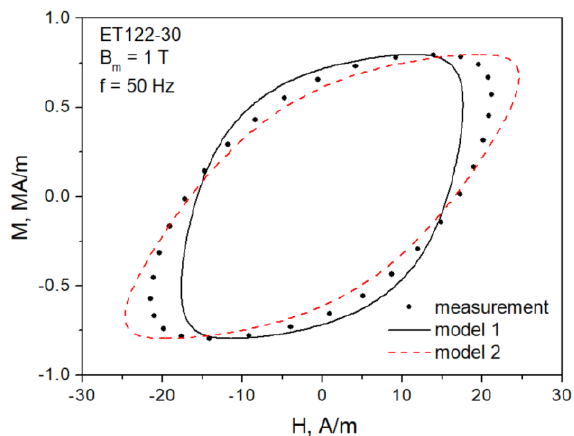
Figure 14. The measured and the modeled minor loops at 𝑓 = 50 Hz.